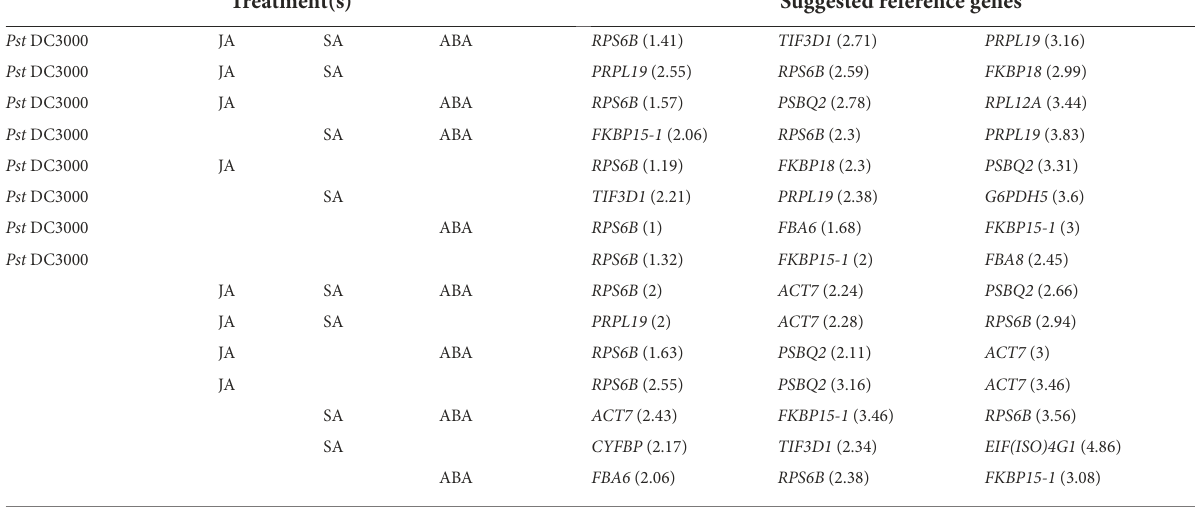
TABLE 1 Appropriate A. thaliana reference genes for expression normalization under different combinations of treatments, including Pseudomonaas syringae pv. tomato DC3000 ( Pst DC3000), jasmonic acid (JA), salicylic acid (SA), and abscisic acid (ABA).